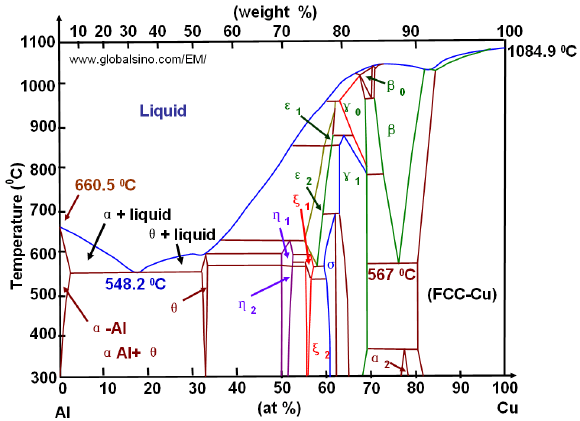
Figure 15. Al-Cu state diagram